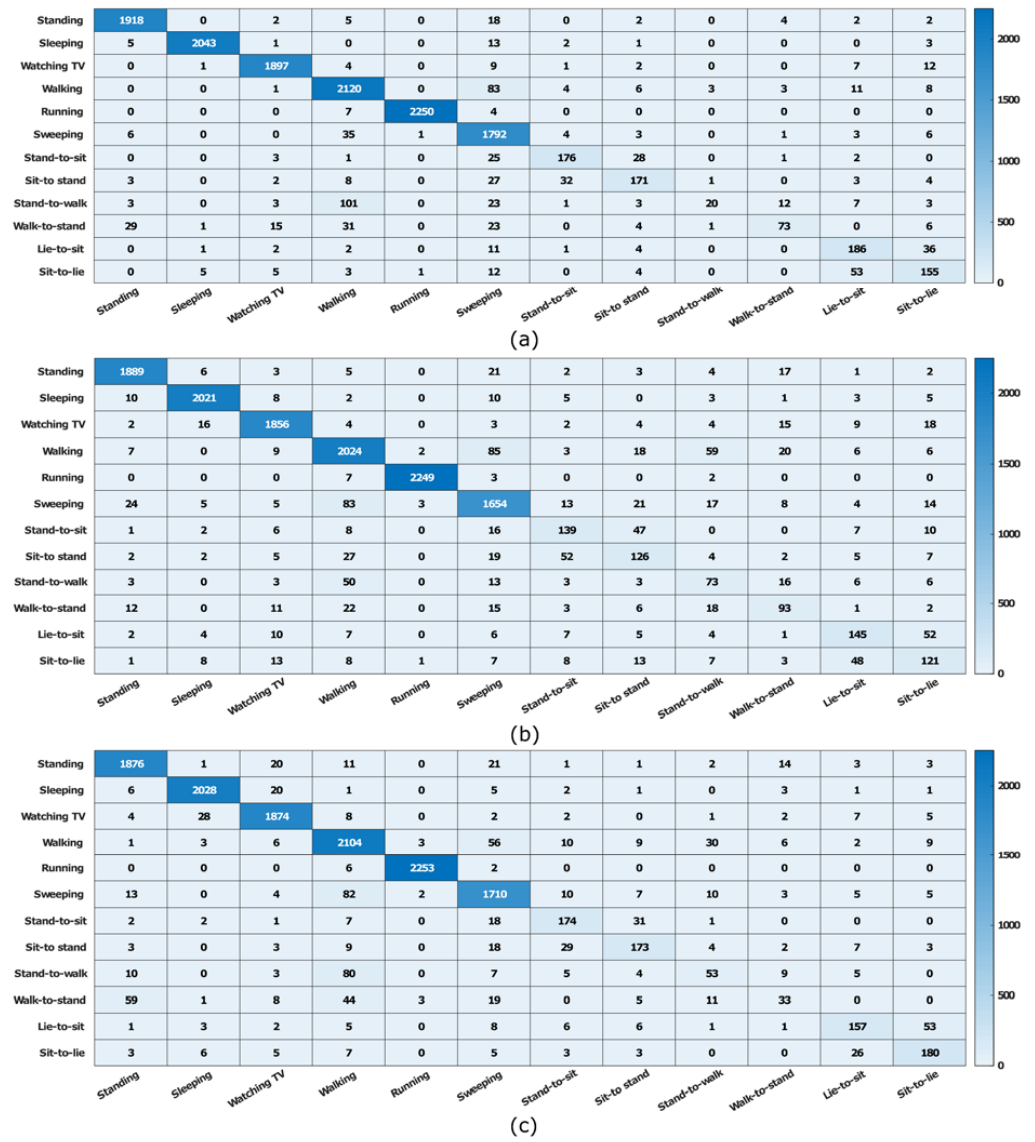
Figure 3. The confusion matrices of twelve activities obtained by SVM ( a ), DT ( b ) and KNN ( c ).